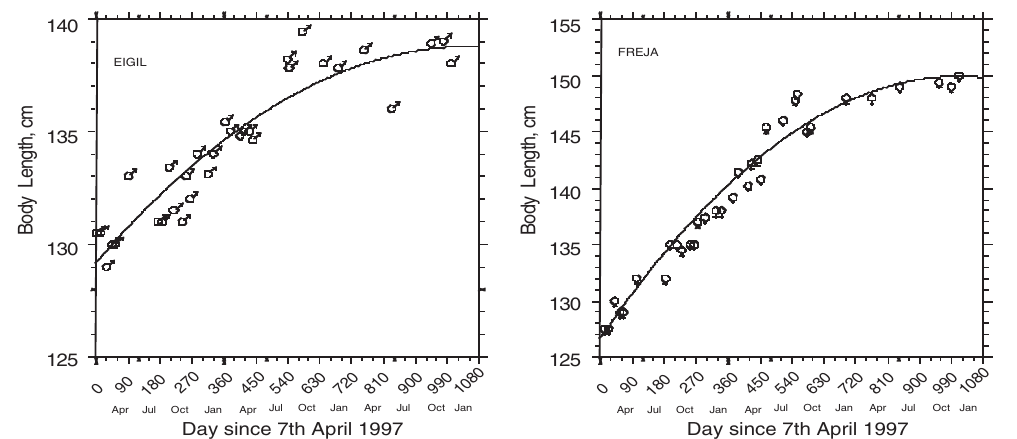
Fig. 4. Growth in body length for Eigil and